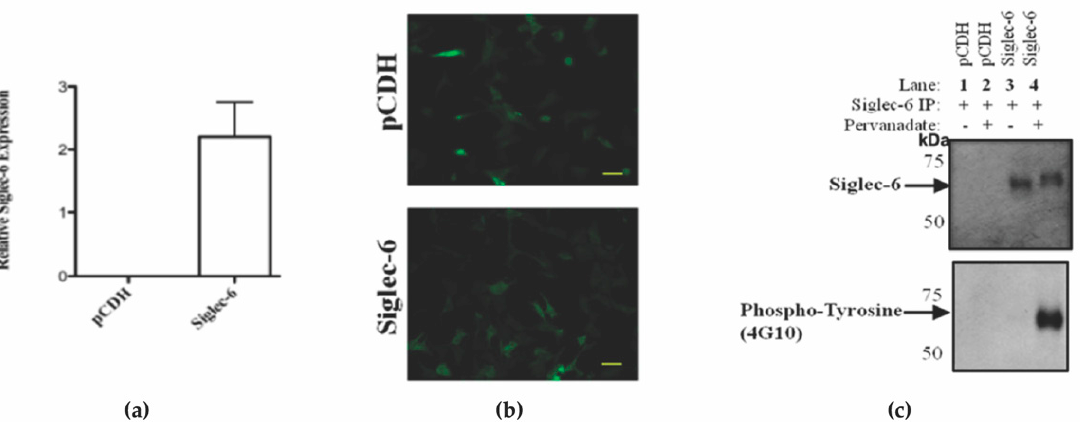
Figure 2. Siglec-6 Stably Expressed in HTR-8/SVneo Cells Undergoes Tyrosine Phosphorylation following pervanadate treatment. Successful transfection of pCDH or Siglec-6 in HTR-8/SVneo cells was confirmed by ( a ) qPCR showing Siglec-6 expression in HTR-8/SVneo cells transfected with pCDH or Siglec-6. (Data are depicted as Mean ± SEM; triplicates) and ( b ) visualizing cellular GFP expression. (yellow bar = 75 µ m). ( c ) Upper panel: immunoblot for Siglec-6 of HTR-8/SVneo cells transfected with either pCDH vector alone or pCDH vector containing Siglec-6 cDNA insert. Lower panel: immunoblot for tyrosine phosphorylation of HTR-8/SVneo cells transfected with pCDH vec- tor alone or containing Siglec-6 cDNA insert plus and minus pervanadate-treatment ( n = 3).